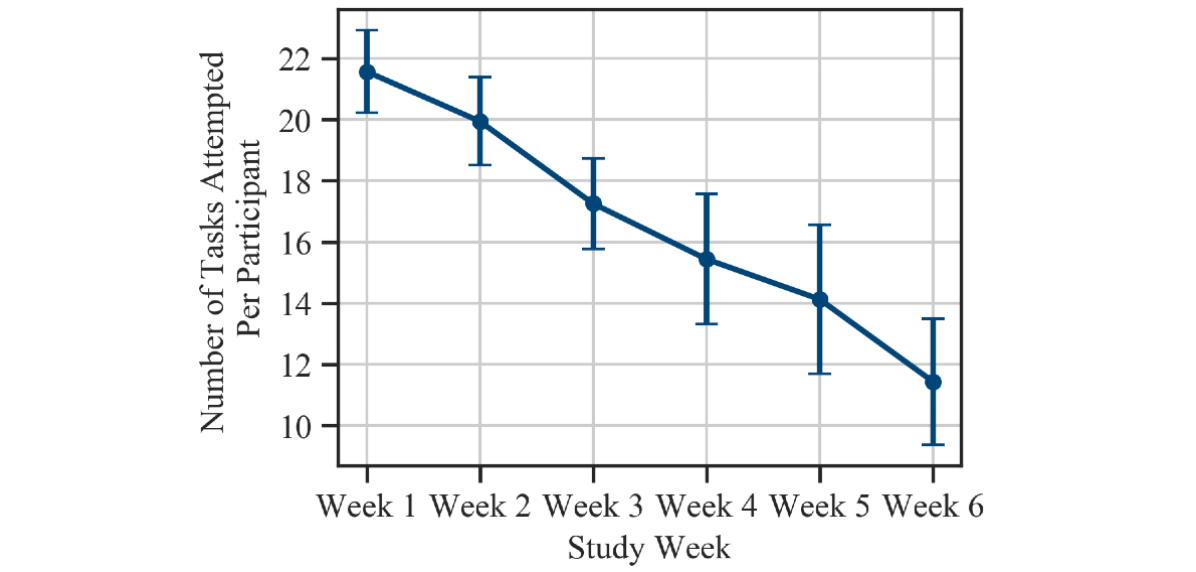
Figure 4. Total number of tasks attempted per participant each week of the study. The markers show the mean across all participants and the error bars indicate the standard error of the mean.